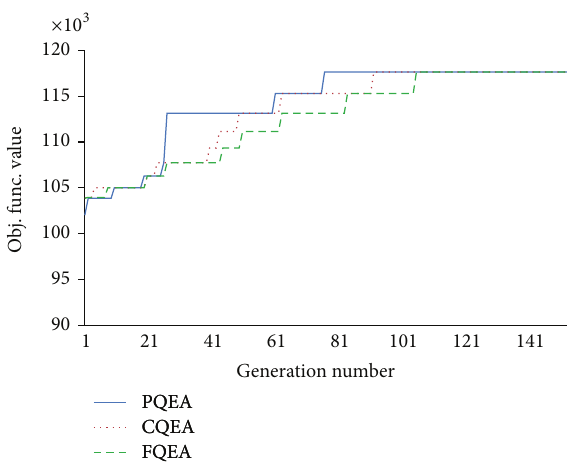
Figure 7: Convergence graph of PQEA, CQEA, and FQEA on COUNTSAT problem size, 𝑛 , being 100.